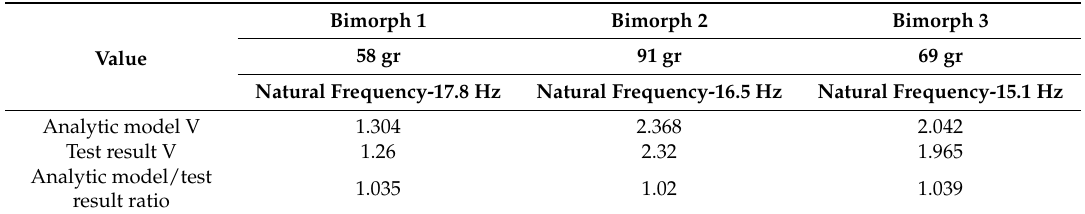
Table 2. Three bimorphs system without spring connections ( K 1 = K 2 = 0)—analytical predictions vs. experimental results.